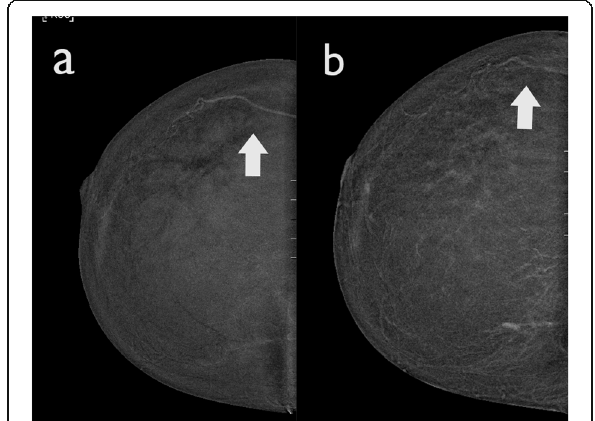
Fig. 6 Transient retention of contrast in blood vessels: a CEDM was performed in a 66-year-old woman to evaluate a suspicious finding in the left breast on mammography. a The right, recombined image shows a bolus of contrast within a blood vessel (arrows); b this artefact disappeared is less promiscuous in the following CEDM acquisition (arrow)